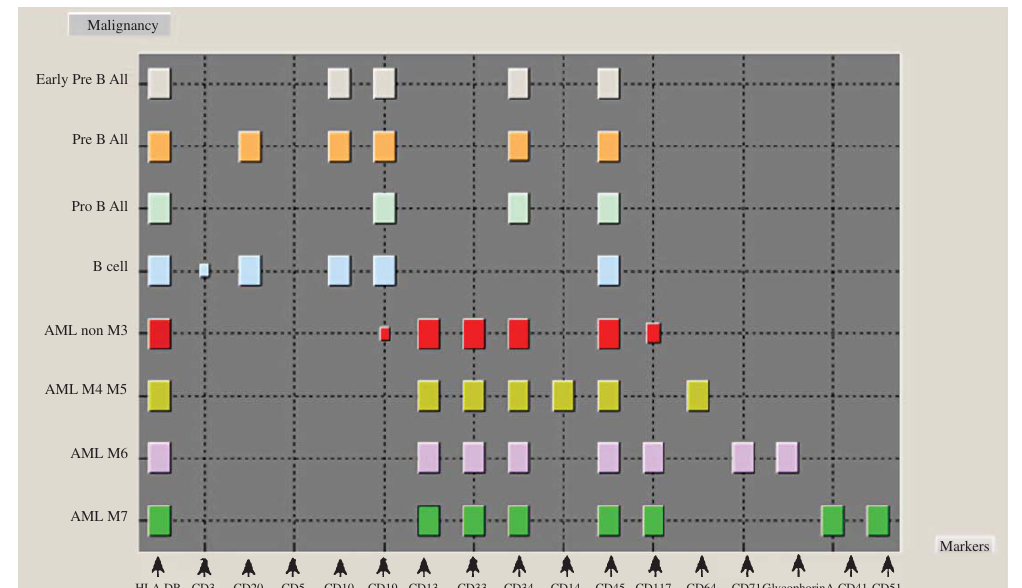
Fig. 5. Hinton Diagram showing